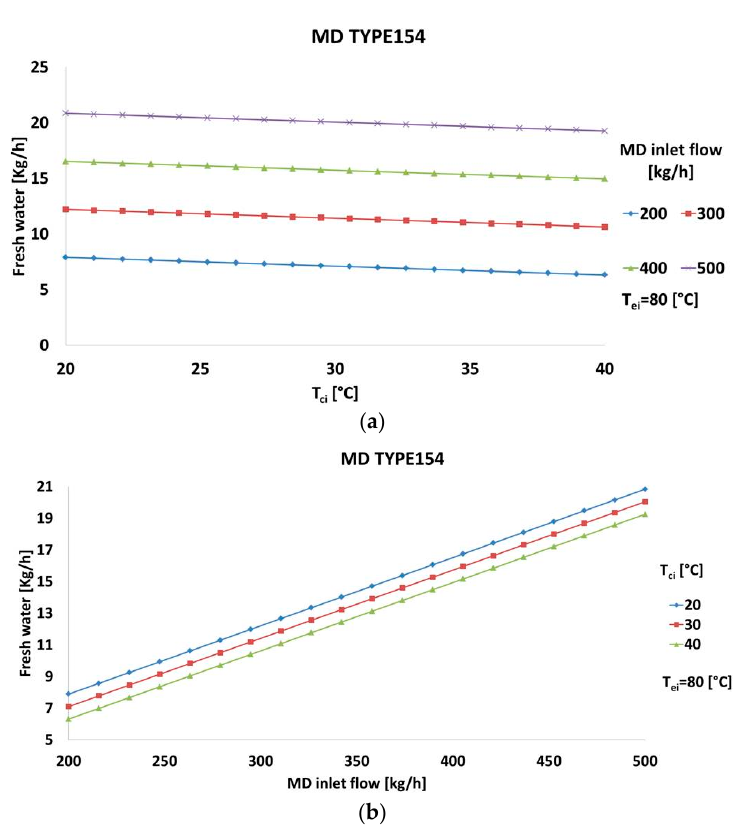
Figure 6. TYPE154 model performance. ( a ) Condenser inlet temperature effect on fresh water production; ( b ) Mass inlet flow effect on fresh water production.